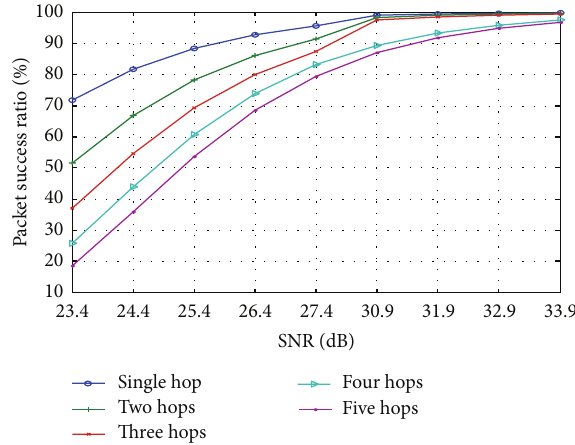
Figure 17: The relationship between the PRR and the SNR for single hop, multihop, and optimal